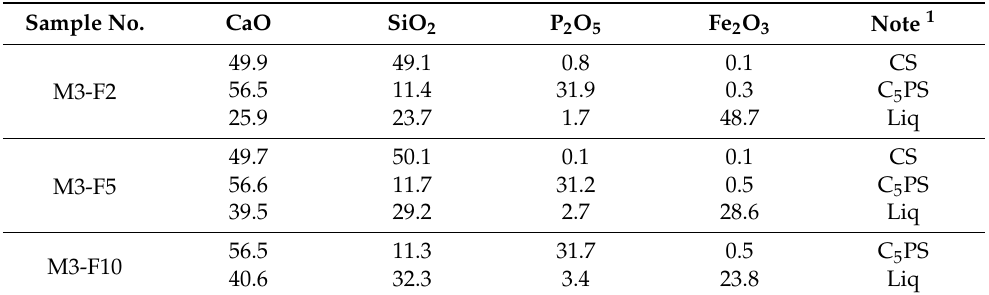
Figure 11. SEM image of M3-F10 (10mass% Fe 2 O 3 ) ( left ) and the phase composition projected on an isothermal section of the CaO-SiO 2 -P 2 O 5 ternary phase diagram at 1573 K ( right ). Table 5. Compositional analysis of the observed phases in the quaternary samples containing Fe 2 O 3 (in mass%).